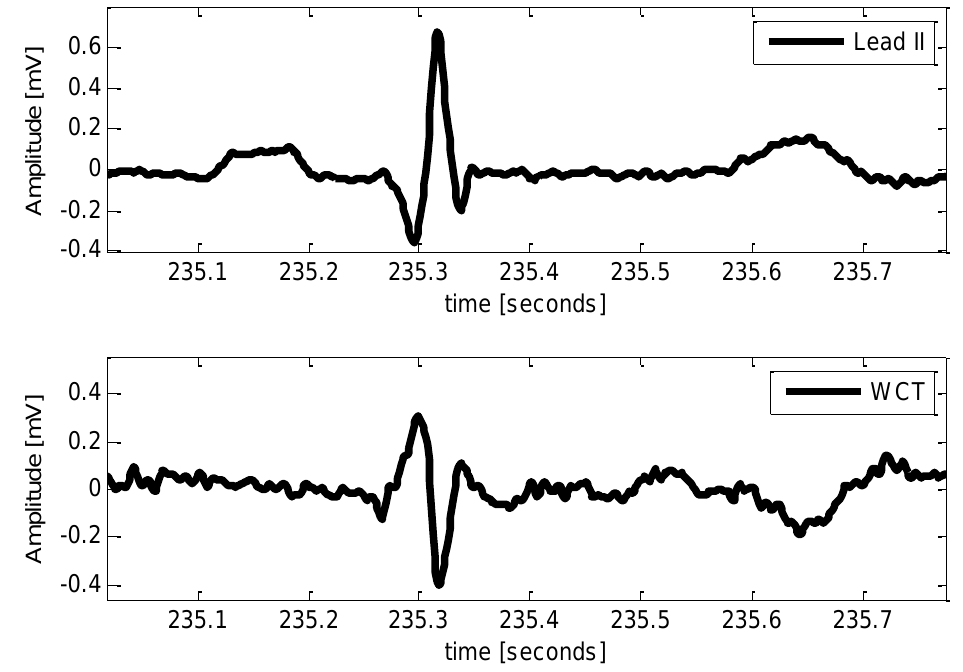
Figure 4 . Example of negative deflection WCT. WCT is 65% of lead II amplitude (average); recording is from a 70-year-old female patient admitted with chest pain. WCT for this patient presents a marked t-wave.